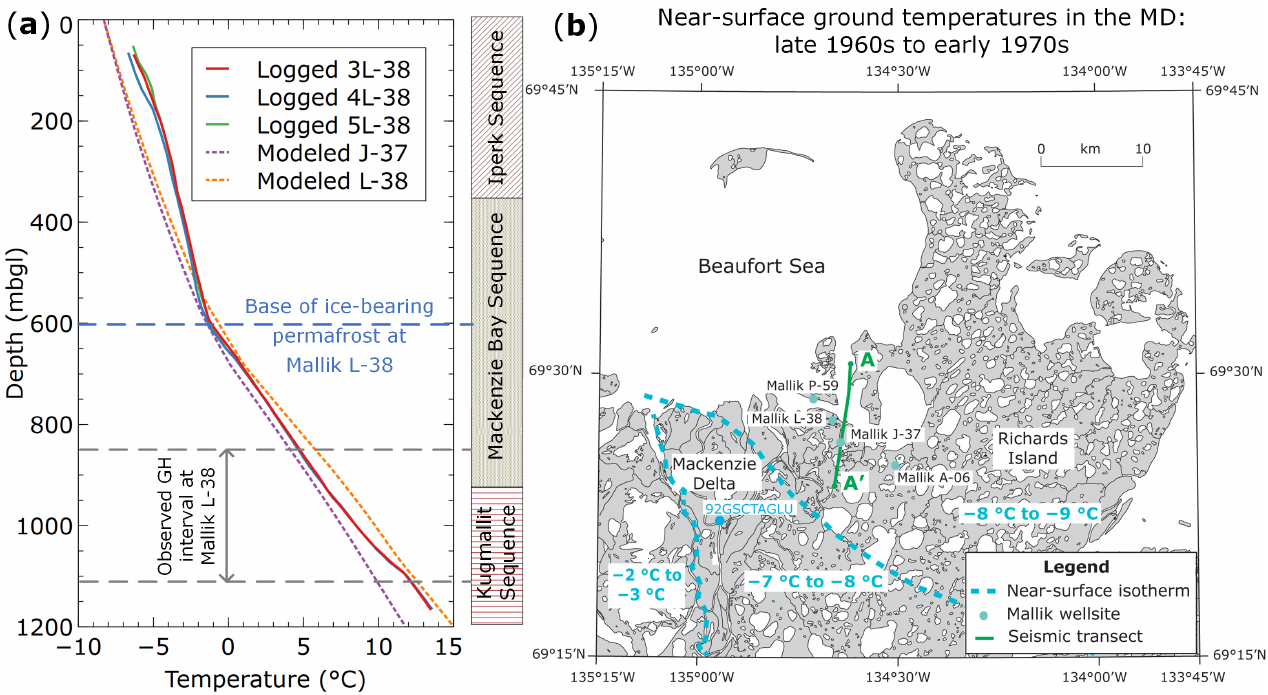
Figure 6. ( a ) Comparison between Distributed Temperature Sensing (DTS)-logged and simulated temperature profiles. The DTS temperature profiles acquired at the Mallik 3L/4L/5L-38 wells were obtained after 622, 605 and 575 days of their completions [81], respectively. Sequence boundaries are modified after [2]; ( b ) map of the near-surface ground temperature distribution in the Macken- zie Delta, in which the representative ground temperature data was collected from hydrocarbon exploration wells developed in the late 1960s and early 1970s, modified after [9]. Figures presented with permission from Natural Resources Canada under the Open Government License—Canada version